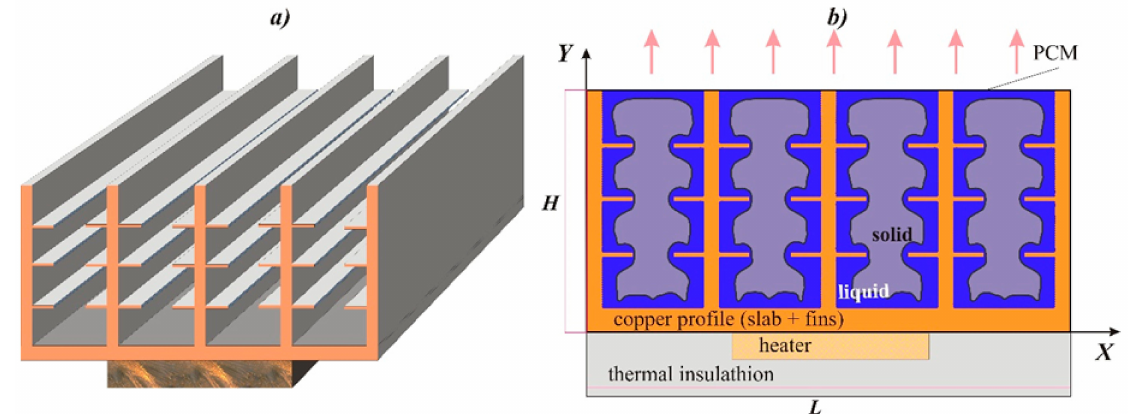
Figure 1. Metal heat sink saturated with PCM (phase change material) and heated from the source. ( a ) 3D shape of the heat sink with the source of volumetric heat generation, ( b ) considered 2D model with